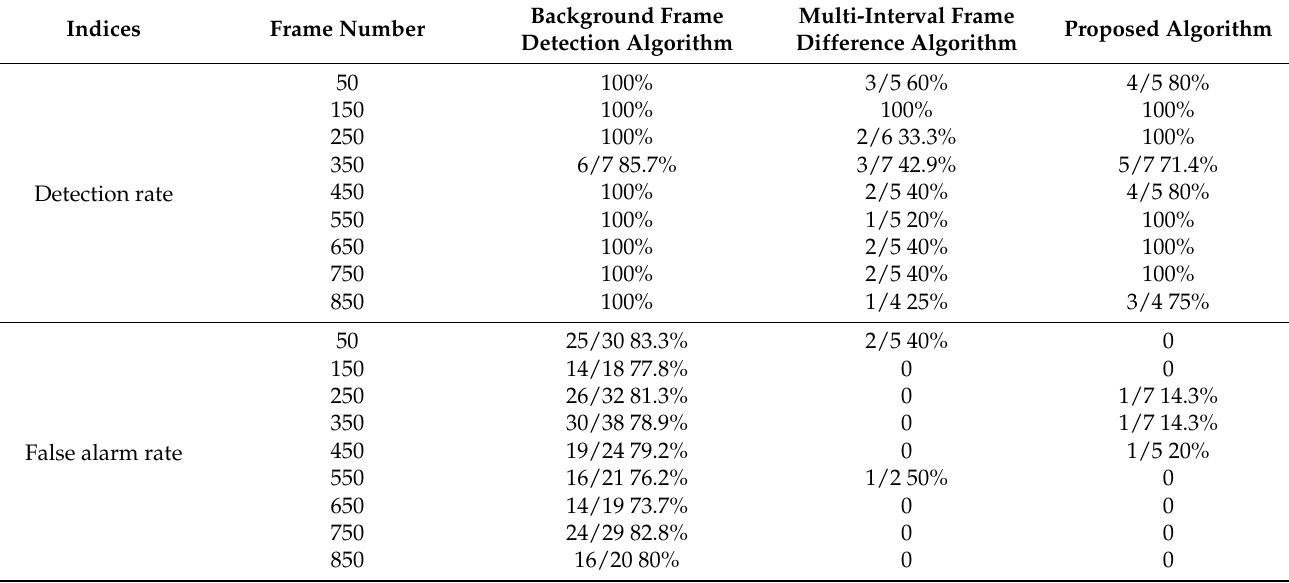
Figure 8. Statistics on detection-related performance of the proposed algorithm. ( a ) Detection rate. ( b ) False alarm rate. Table 1. Comparison of detection-related performance of three algorithms.